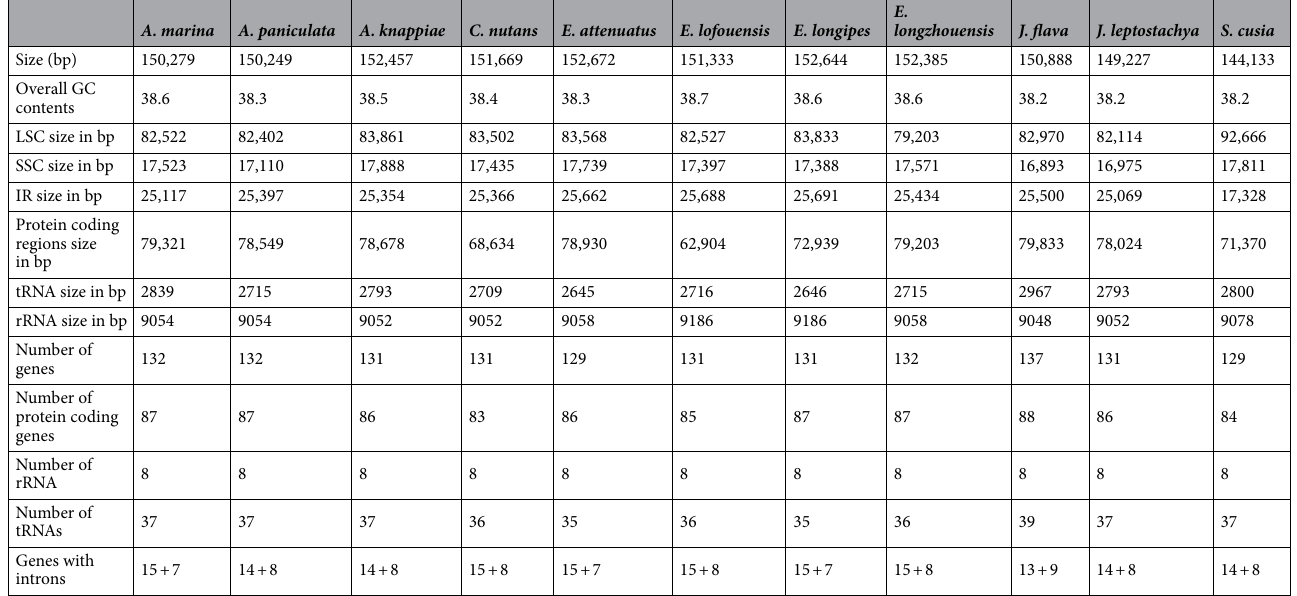
Table 1. Genomic details and statistics of 11 mangrove species of the family Acanthaceae.